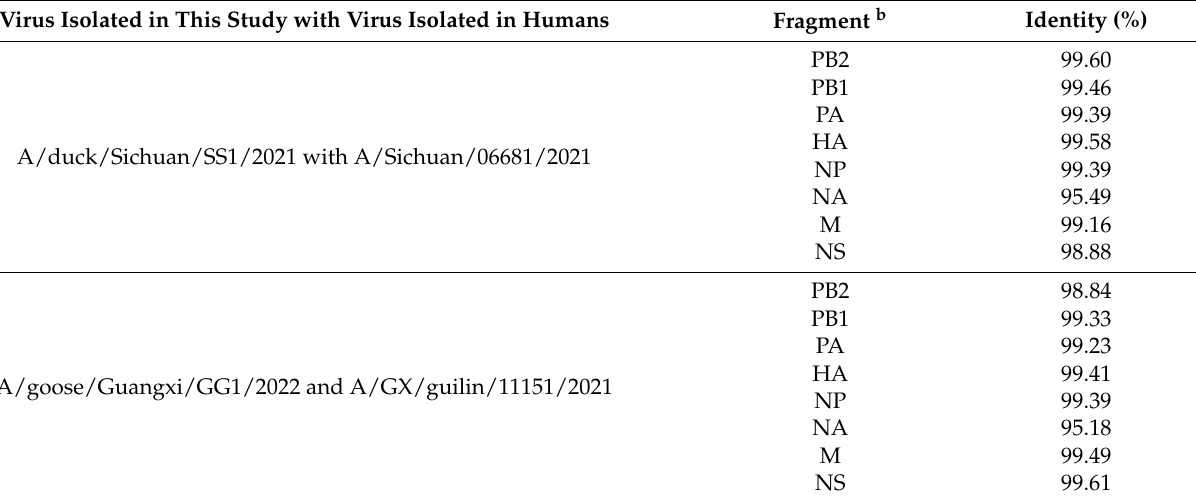
Table 1. Nucleotide sequence identity between the virus isolated in this study with virus isolated in human available in GISAID a